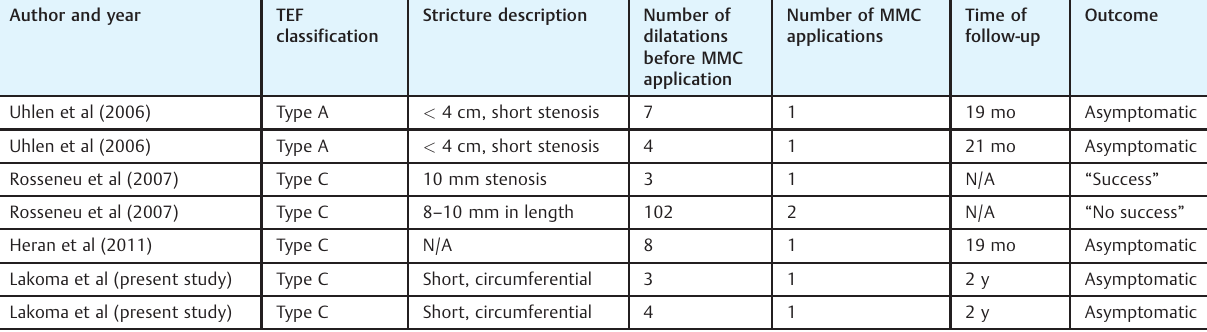
Table 1 Literature review of mitomycin C (MMC) used for esophageal strictures following surgical repair in the neonatal period for variants of tracheoesophageal fi stula (TEF) with esophageal